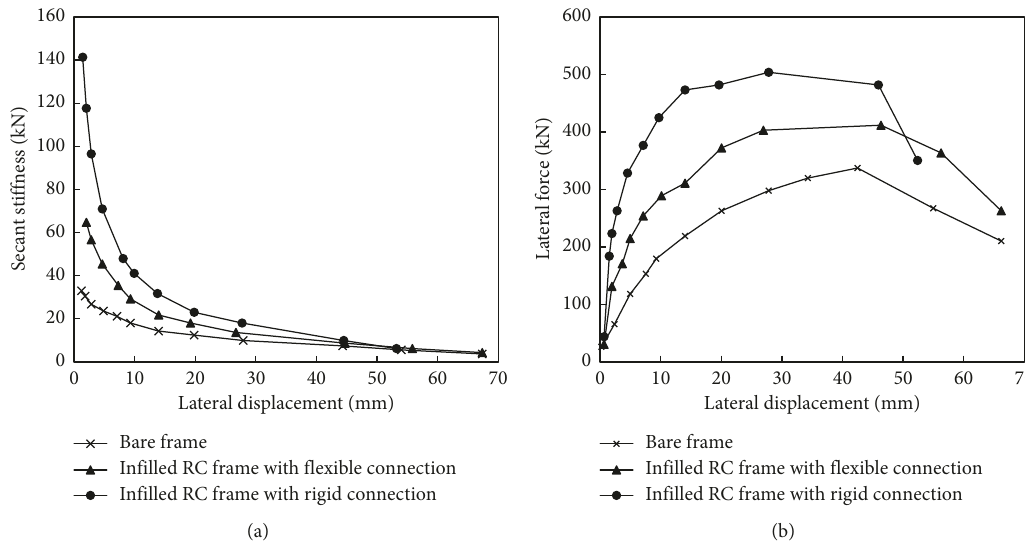
Figure 7: (a) Stiffness degradation of two specimens provided by reference [11]; (b) deformation failure processes of three specimens provided by reference [11].